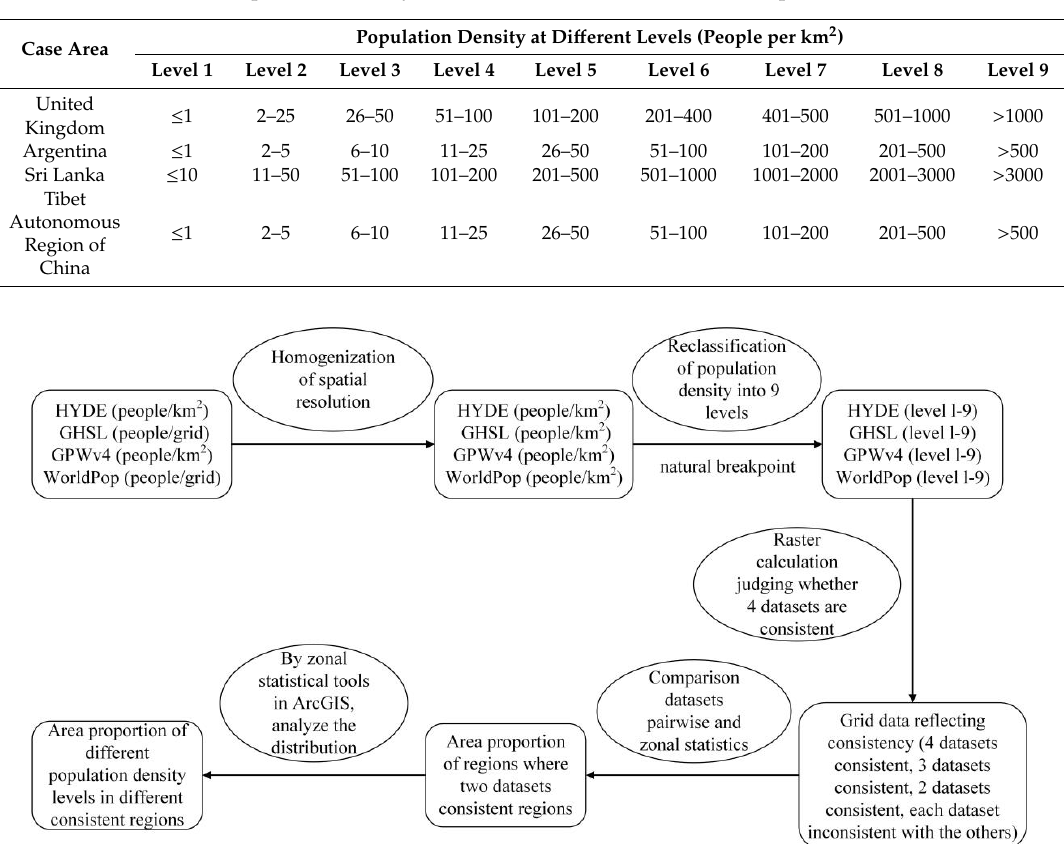
Table 3. Population density classification based on natural breakpoint method.